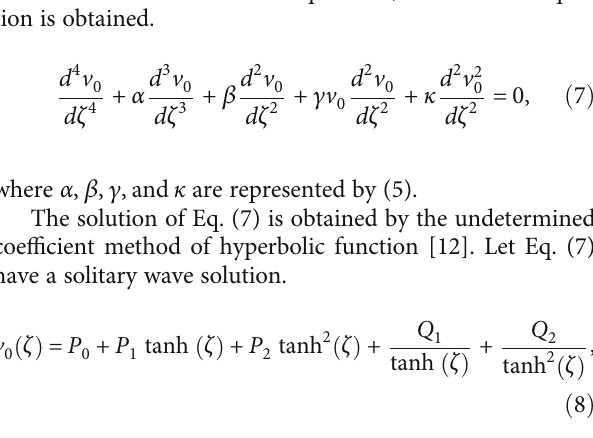
Figure 1: Illustration for the zeroth solitary wave v quantum plasma electrostatic potential ð T 0 = 0, T 1 = 10 Þ ( ζ for the abscissa, v 10 ð ζ Þ for the ordinate).